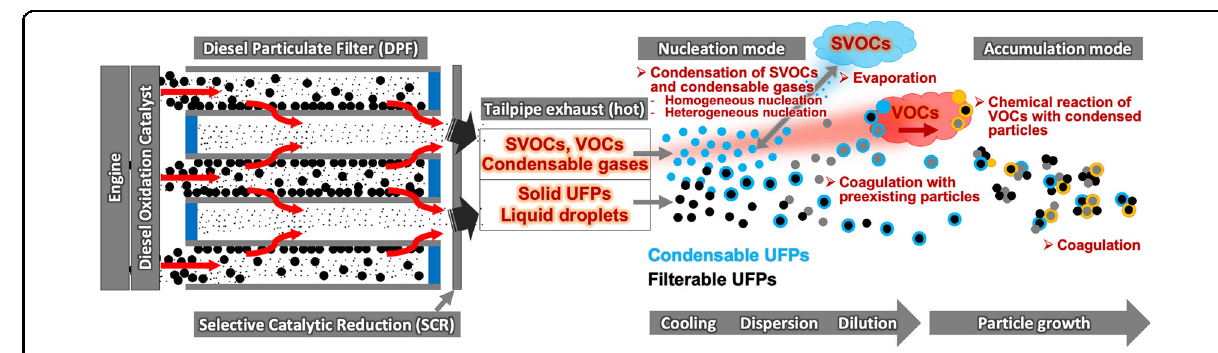
Fig. 4 The dynamics of ultra fi ne particles emitted from a typical diesel engine. A signi fi cant amount of volatile organic compounds (VOCs) and semivolatile organic compounds (SVOCs) are catalyzed, and removed within the diesel oxidation catalyst (DOC). Most of the coarse and fi ne fi lterable particles are fi ltered within the diesel particulate fi lter (DPF). Solid ultra fi ne particles (UFPs), VOCs, SVOCs, and other condensable gases that escape the DOC and DPF are emitted via the tailpipe. As they are released, the hot gas cools, and SVOCs and some gases condense to form tiny nucleation mode particles. The process of vapors condensing homogeneously upon cooling to form UFPs, usually <50 nm, is called homogeneous nucleation. The process of vapors condensing on the surface of other existing UFPs or larger particles is called heterogeneous nucleation. When the exhaust gas is dispersed and diluted in ambient air, UFPs coagulate to form larger particles. Some condensed SVOCs evaporate and return to the gas phase; some coagulate with preexisting fi ne particles in the ambient air. The coagulation and evaporation process rapidly diminishes the particle number of the nucleation mode. VOCs that were emitted together may condense on the liquid aerosols and form secondary organic aerosols by chemical reactions. Particles grow in size, agglomerate, and thus increase the number of accumulation